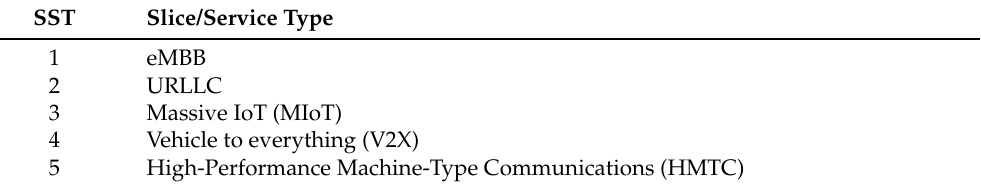
Table 1. Standardized SST values